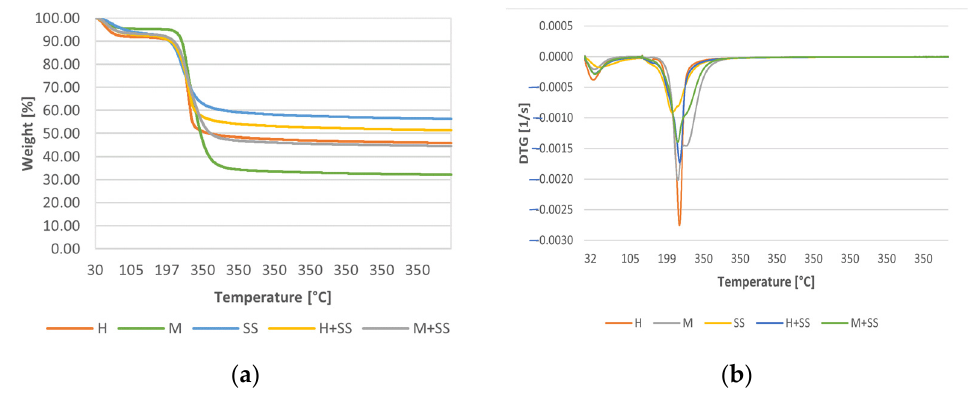
Figure 6. TGA ( a ) and DTG ( b ) curves for all materials, torrefied at 350 °C for 60 min.